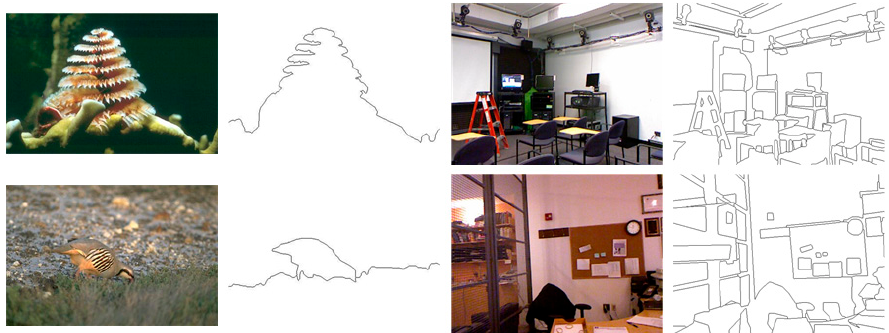
Table 5. Effect of coefficient  .